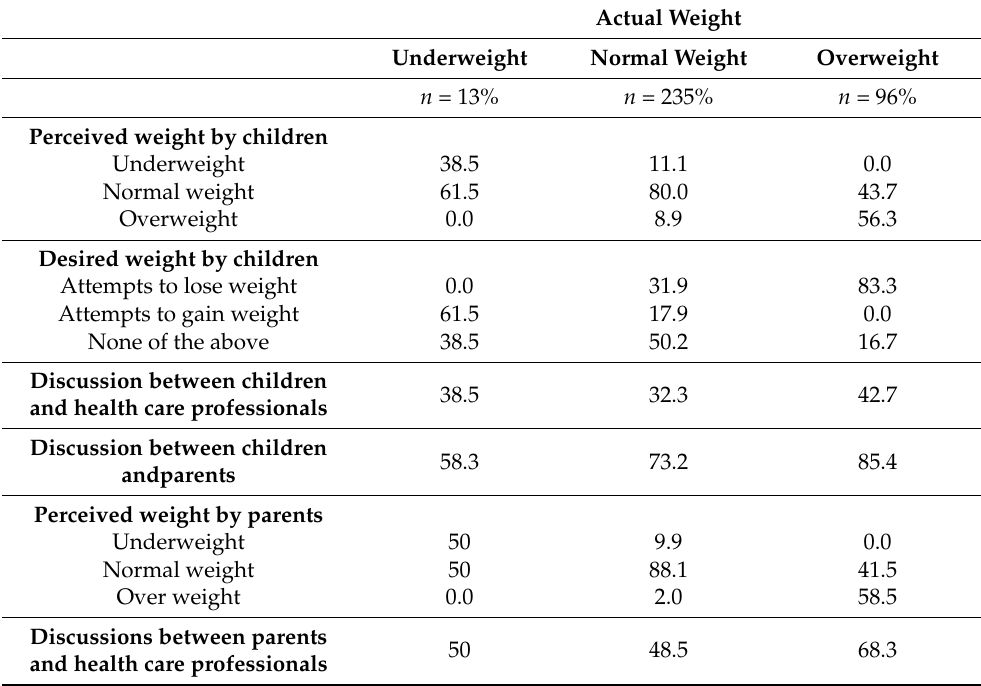
Table 1. Actual weight, perceived weight and desired weight among Romanian school